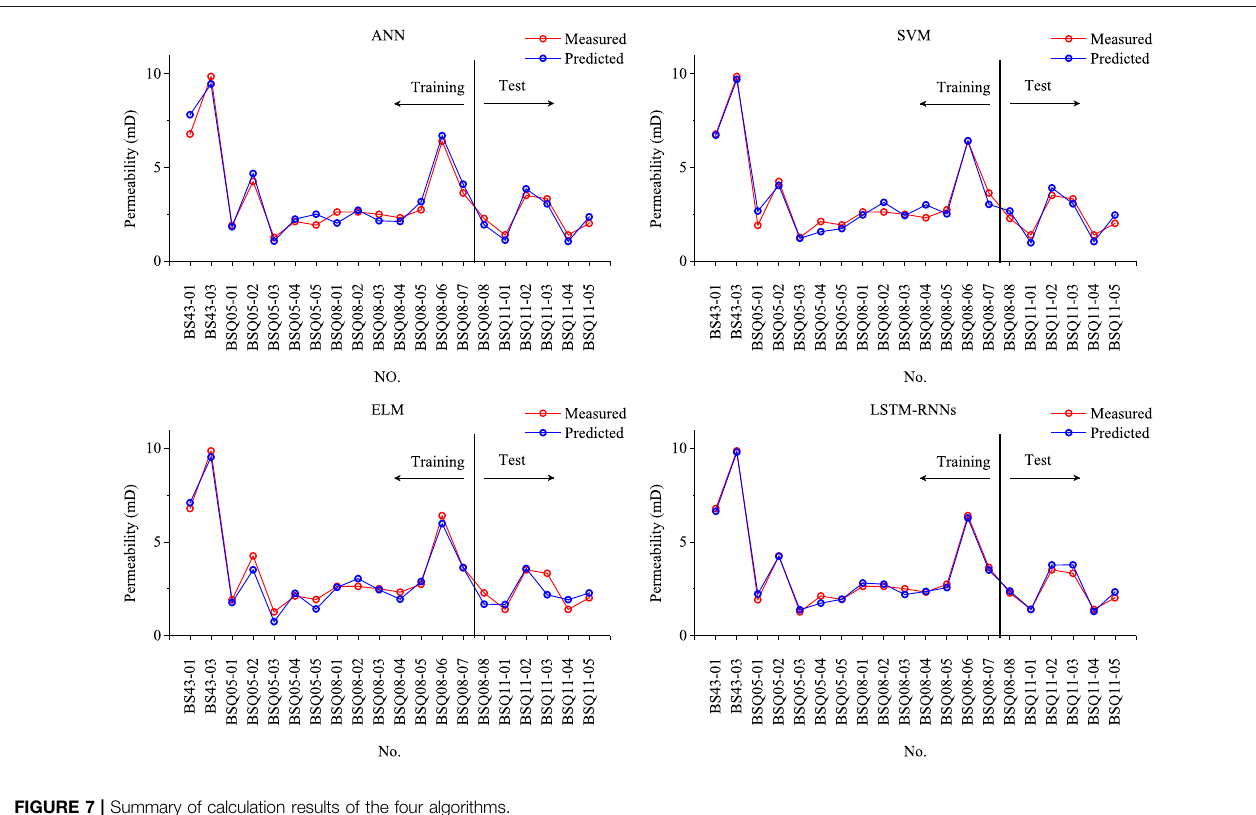
FIGURE 7 | Summary of calculation results of the four